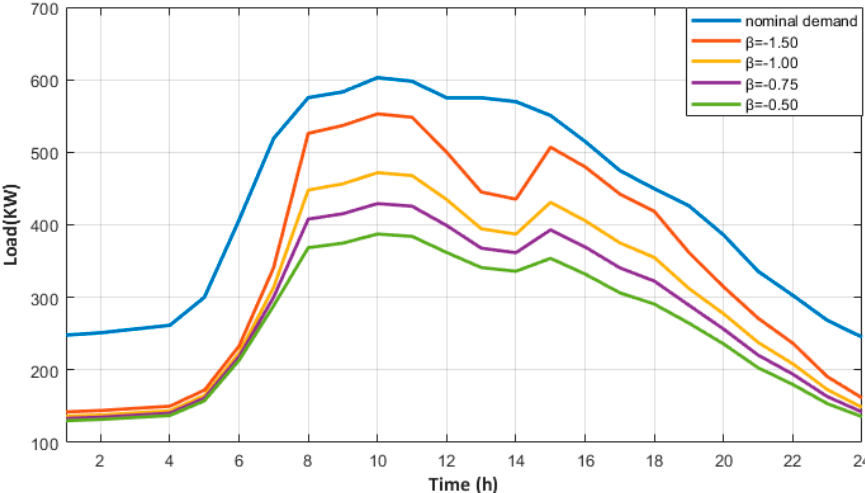
Figure 13. Nominal demand and final demand per elasticity values. (source: Authors). Table 10. Contribution of the two procurement mechanisms for S1 and S8.